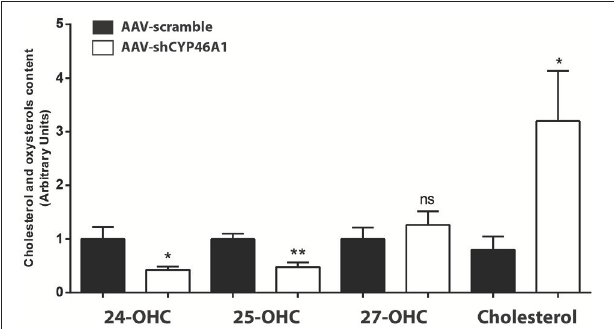
FIGURE 1 | Measurement of cholesterol and oxysterols content 4 weeks after hippocampal injection of AAV-shCYP46A1 vector. AAV-scramble (control) or AAV-shCYP46A1 vector was injected in the stratum lacunosum moleculare of hippocampus in C57BL/6 mice. Sterols were extracted, derivatized and analyzed by UPLC-ESI-Q-TOF in MS scan mode. Cholesterol, 24-, 25-, and 27-hydroxycholesterol contents were quantified and normalized to AAV-scramble content ( n = 5 mice). Unpaired t -test was performed. * P < 0.05, ** P < 0.01; ns,